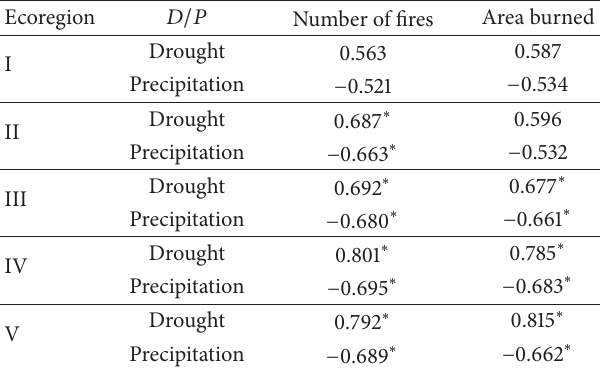
Table 3: Spearman’s correlation coefficient between precipitation amounts, drought index values, and fire activity in fire season for five ecoregions in Yunnan province, during the period 1982–1988.